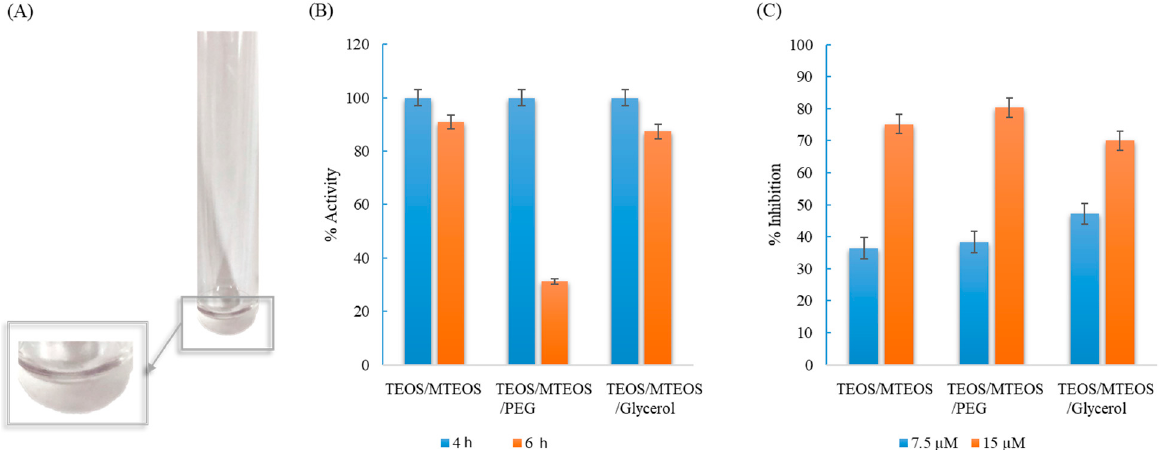
Figure 5. ( A ) Developed TEOS/MTEOS sol–gel sensor in the polystyrene tube. ( B ) % of remaining activity in the developed devices at different time to heat the device in the oven at 40 °C. ( C ) % reaction inhibition as function of nitrogen concentration (7.5 µM and 15 µM).